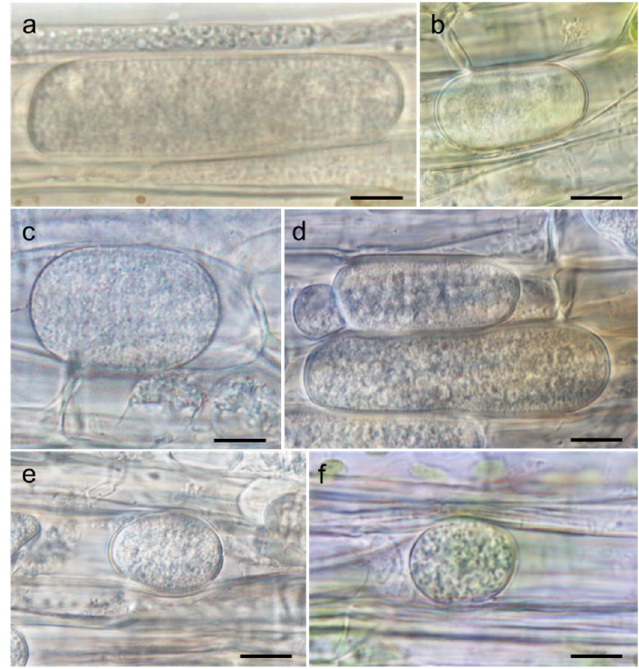
Figure 5. Production of sporangia and hyphal swellings of Globisporangium spp. isolated from a single colony of Sanionia moss in Ny-Ålesund, Spitsbergen Is., Norway in host plant tissues under an in vitro inoculation at 4 to 10 °C: ( a ) hyphal swelling of Globisporangium sp. 1 strain 10G16V2; ( b ) sporangium of Globisporangium sp. 2 (= G. polare ) strain 18G12N1; ( c ) sporangium of Globisporangium sp. 3 strain 18C32N1; ( d ) sporangium of Globisporangium sp. 4 strain 18C32N1; ( e ) sporangium of Globisporangium sp. 5 strain 18G13N1; and ( f ) hyphal swelling of Globisporangium sp. 6 strain 18C14N1. Bars = 10 µm. Table 1. Infectivity of Globisporangium spp. from the Sanionia moss in Ny-Ålesund to Sanionia uncinata in an in vitro inoculation test. Temperature Infection into the Host Plant Cells with; Recovery from the Taxonomic Group Strain Oospores or Host Plant( ◦ C) Hyphae Sporangia Globisporangium sp. 1 Globisporangium sp. 2 ( G. polare ) Globisporangium sp.